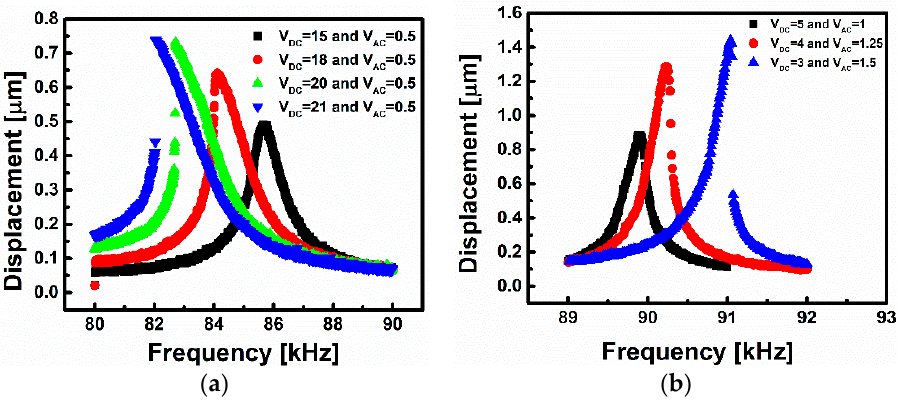
Figure 4. Frequency response curves, obtained through forward sweeps, of the clamped-clamped microbeam ( a ) for different DC voltages showing a transition from a linear to a softening behavior at 3.3 Torr; and ( b ) for different AC voltages showing the transition from linear to hardening behavior at 220 mTorr.